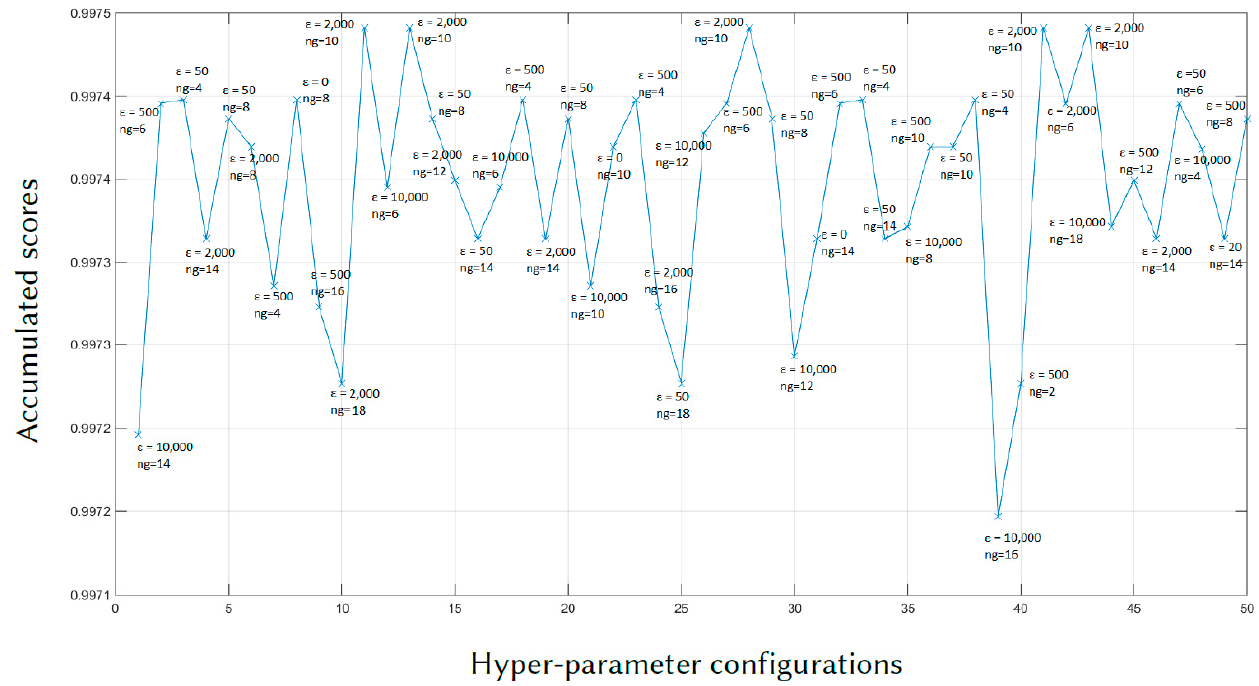
Figure 3. The plot of accumulated scores for all hyperparameter configurations at the end of the proposed method.